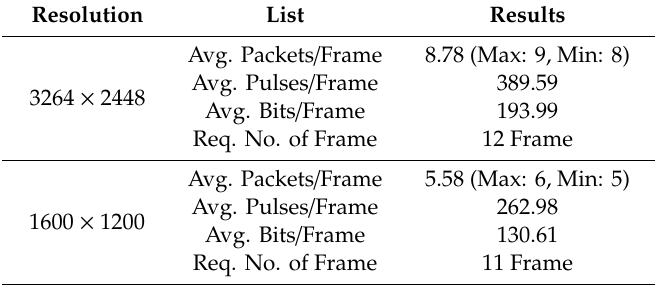
Table 1. Received streaming data consisting of 52 fragmented packets (sequential transmission).